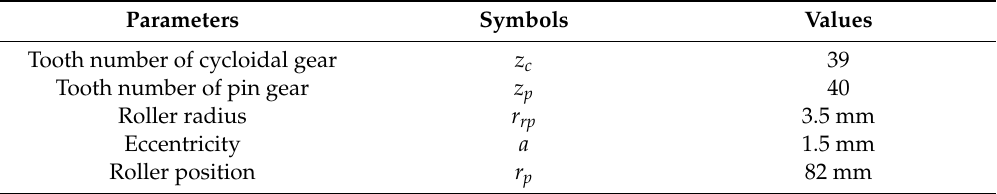
Figure 3. Pressure angle distribution of the single tooth profile. Table 1. Geometric parameters of the cycloid-pin